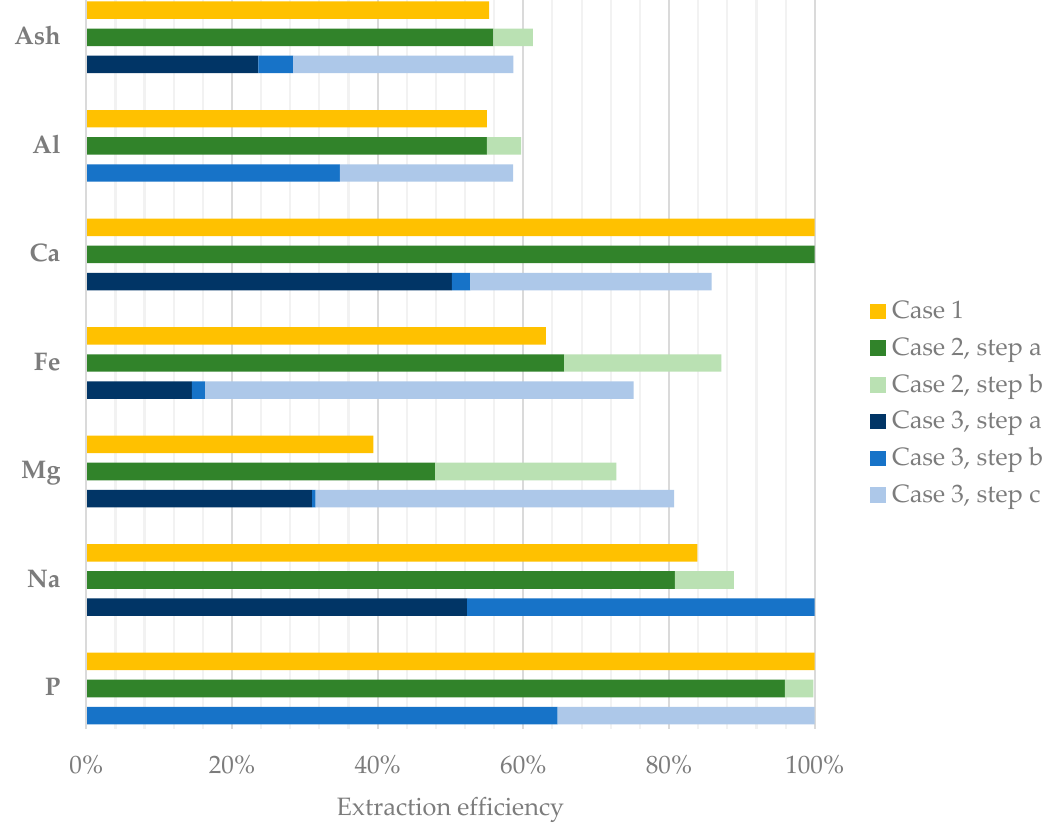
Figure 3. Extraction efficiency of ash and main inorganic elements achieved by the performed test cases (1–3).